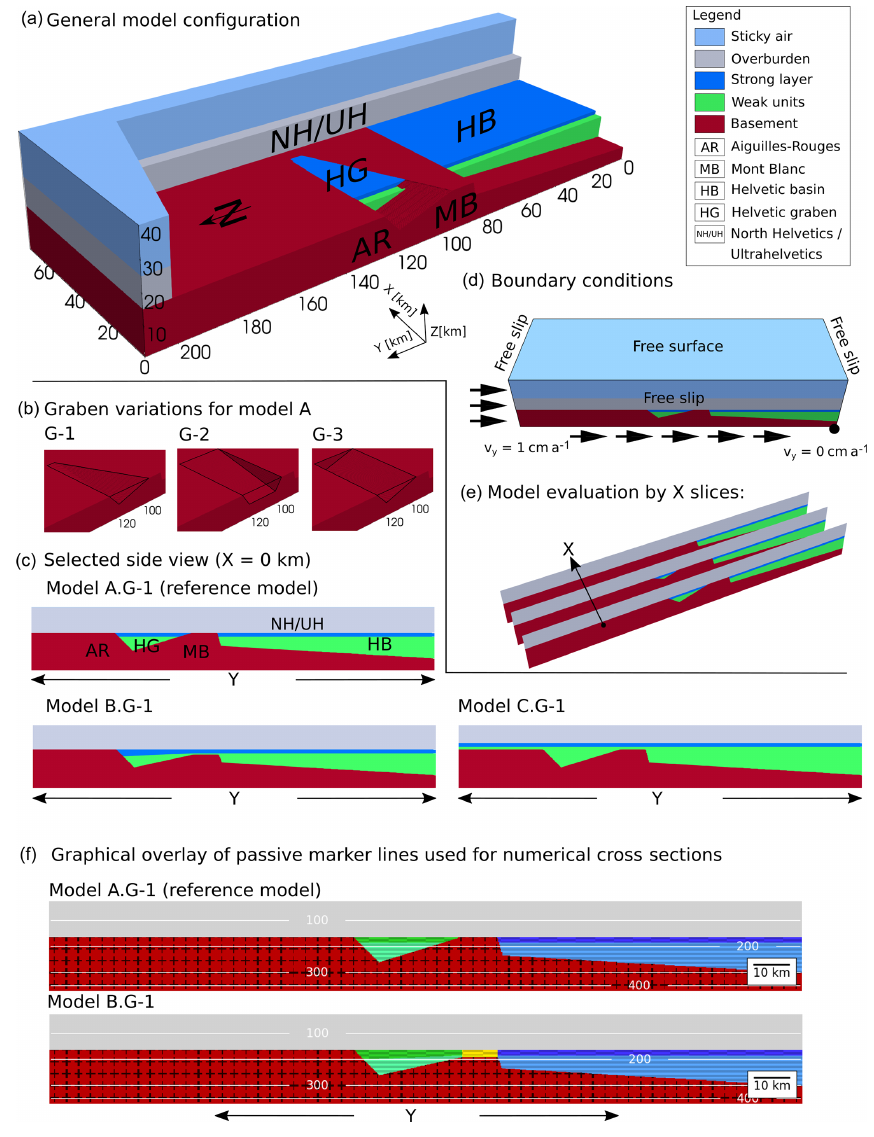
Figure 3. (a) 3-D geometry of our reference model configuration using a laterally disappearing half-graben and highlighting the distribution of our numerical phases and their material properties. Here, the colour green refers to weak materials and dark blue to strong materials. The configuration is based on the palaeogeographic reconstructions as indicated by the abbreviations on the model: AR represents Aiguilles Rouges massif, MB represents Mont Blanc massif, HB represents Helvetic basin, NH/UH represents North Helvetic Flysch and Ultrahelvetic units, and HG represents North Helvetic graben. (b) Display of our three different half-graben systems used as initial setup. (c) Cross-sectional view at X = 0km for three models utilizing half-graben G-1 in combination with three different stratigraphic distributions. (d) Sketch displaying our boundary conditions. (e) Three cross-sectional slices along the X direction to explain our model evaluation. (f) Subfigure highlighting our passive marker overlay, which is used to distinguish the different structural units, HG (green) and HB (blue), from each other. Temperature isotherms are shown in degrees Celsius ( ◦